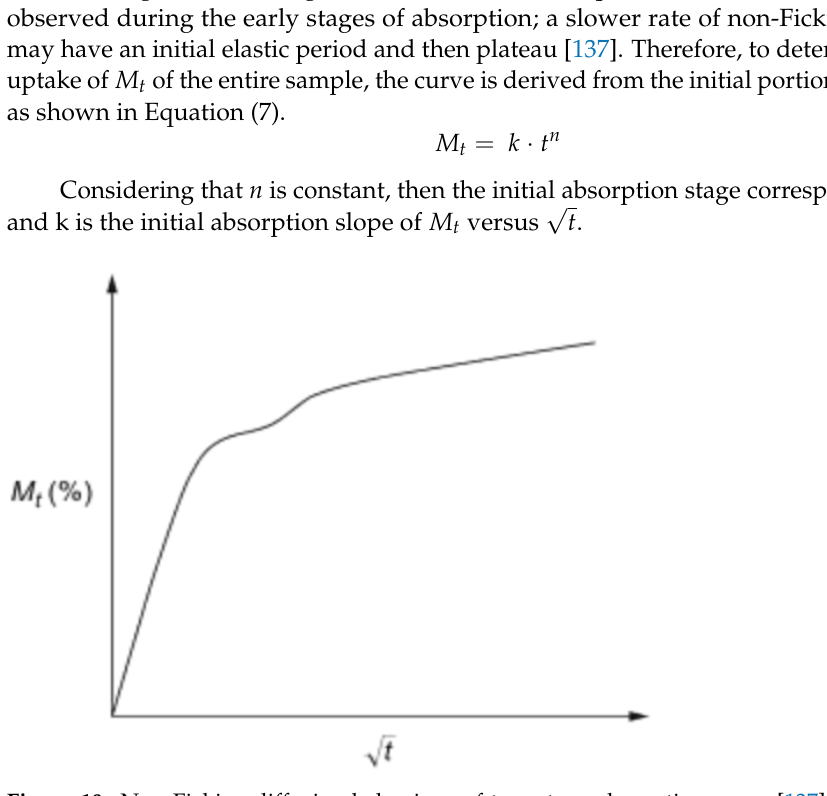
Figure 10. Non-Fickian diffusion behaviour of two-stage absorption curve [137] (reprinted with permission from Elsevier, Licence Number: 5447061247707). Table 4. Water ingress mechanism of pure and modified sisal composites [120].